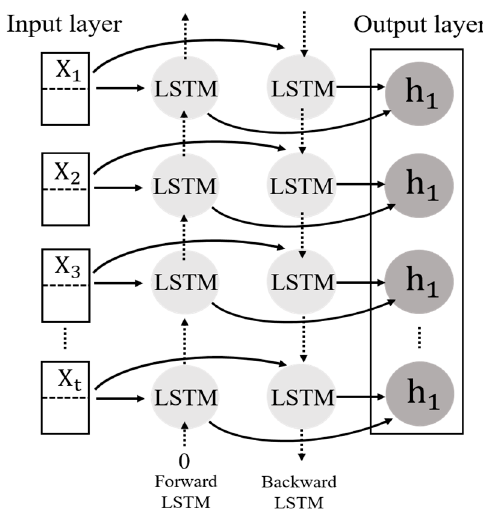
Figure 3. The Bi-long short-term memory (LSTM) process used to capture sequential features. The last hidden layer of the LSTM is extracted as features representing the text.